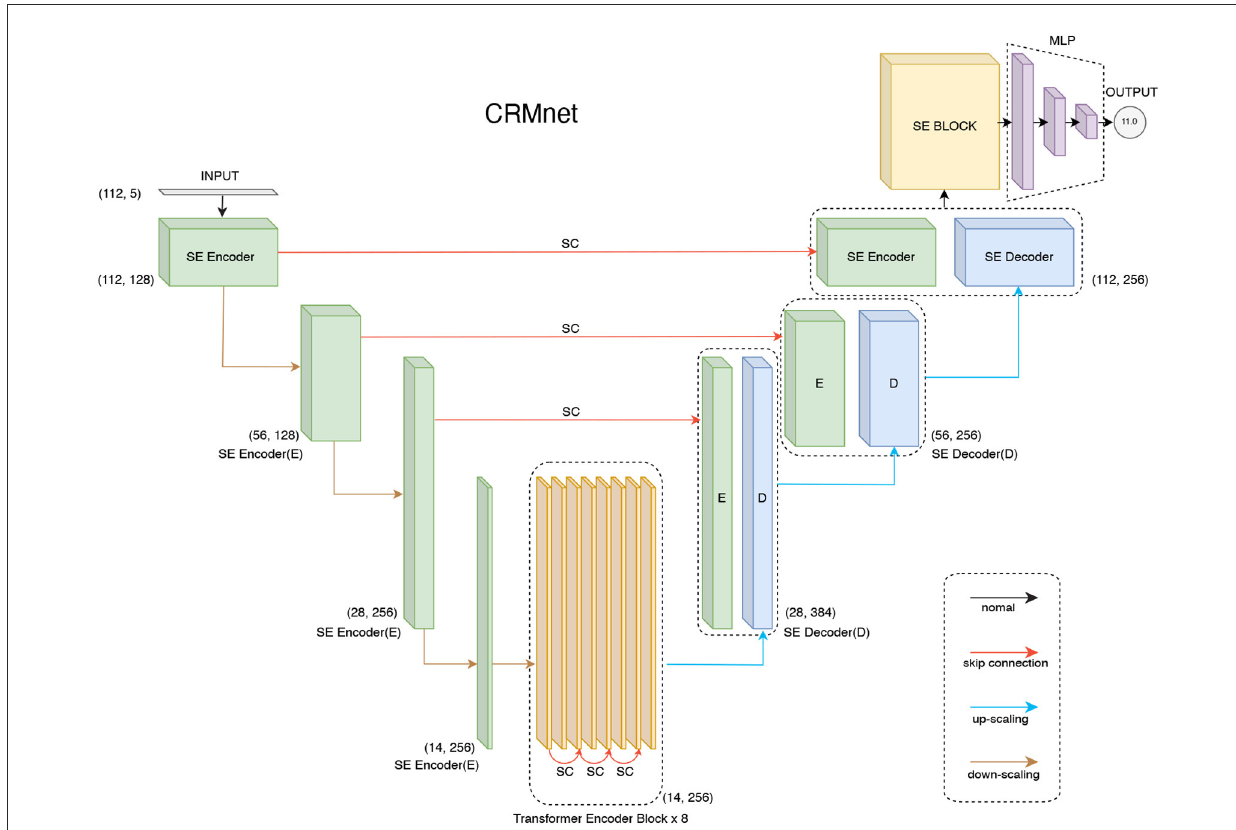
FIGURE1 CRMnet model’s architecture. Our CRMnet consists of Squeeze and Excitation (SE) Encoder Blocks, Transformer Encoder Blocks, SE Decoder Blocks, SE Block and Multi-Layer Perceptron (MLP). Similar to the U-Net architecture, the encoder and corresponding decoder at the same level have a skip connection (SC) so the decoder utilizes the concatenation of the upsampled feature map with the corresponding higher resolution encoder feature map at that